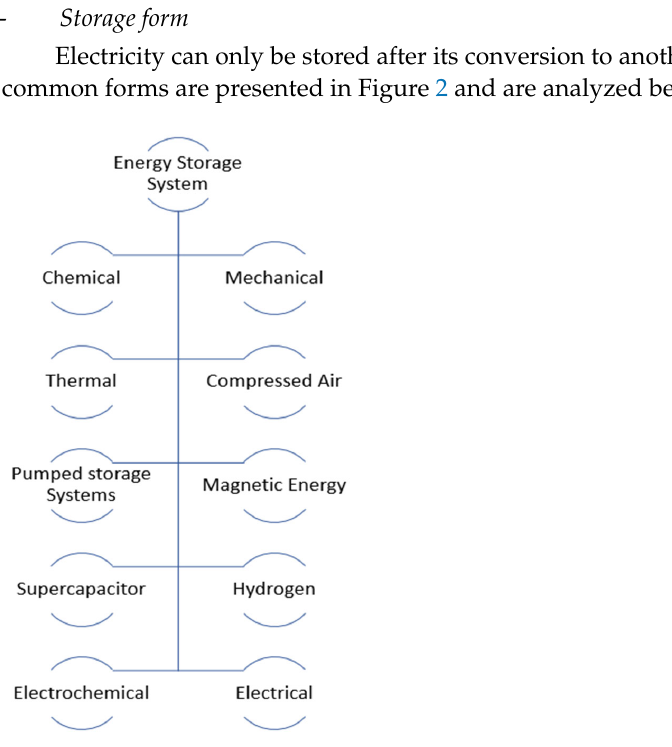
Figure 2. Energy storage systems categories.